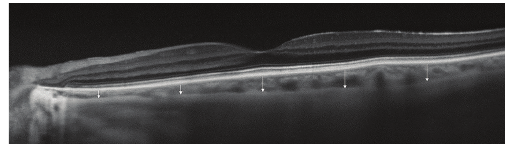
Figure 1: Optical coherence tomography scan, showing the macular choroidal thicknesses at five different locations (subfoveal, 1.5mm nasal to the fovea, 3 mm nasal to the fovea, 1.5mm temporal to the fovea, and 3 mm temporal to the fovea).